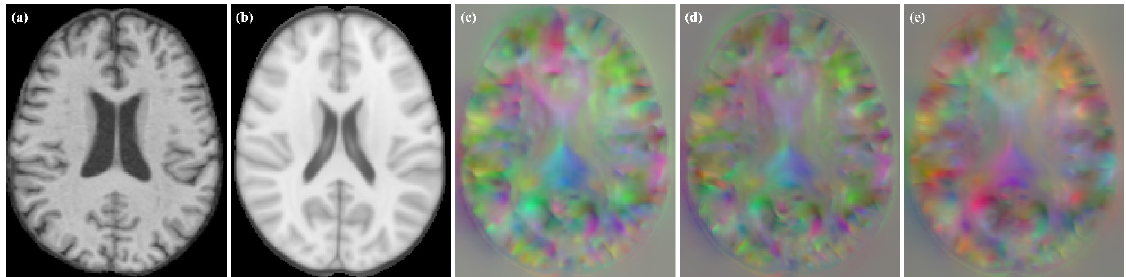
Figure 8. The fusion results for different methods. The positions of det ( D φ − 1 ) < 0 are marked in red. From left to right: AAW method; MIScnn; patchify and our proposed.